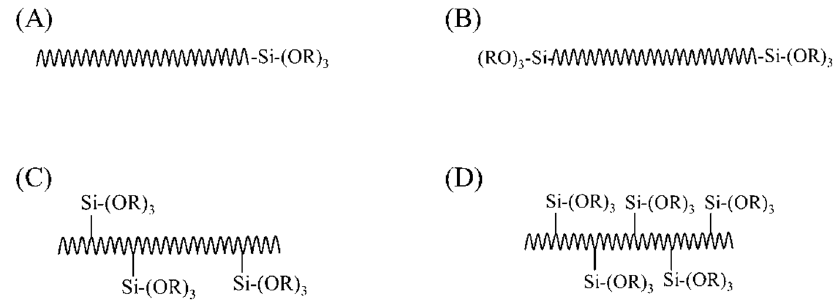
Figure 4. Various types of functionalization of polymer with trialkoxysilane ( A ) monofunctionalization ( B ) difunctionalization; pendant functionalization with side chains ( C ) random copolymerization ( D ) block copolymerization.